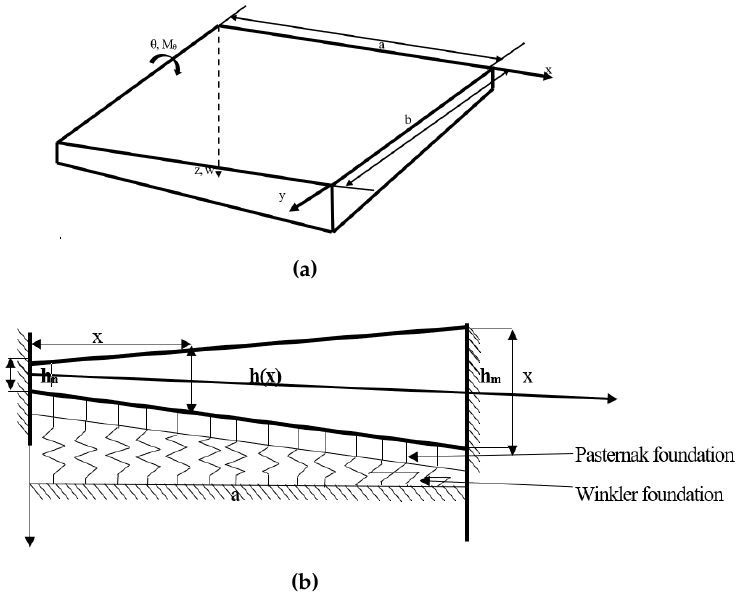
Figure 1. Geometry of rectangular plate of varying thickness resting on two-parameter